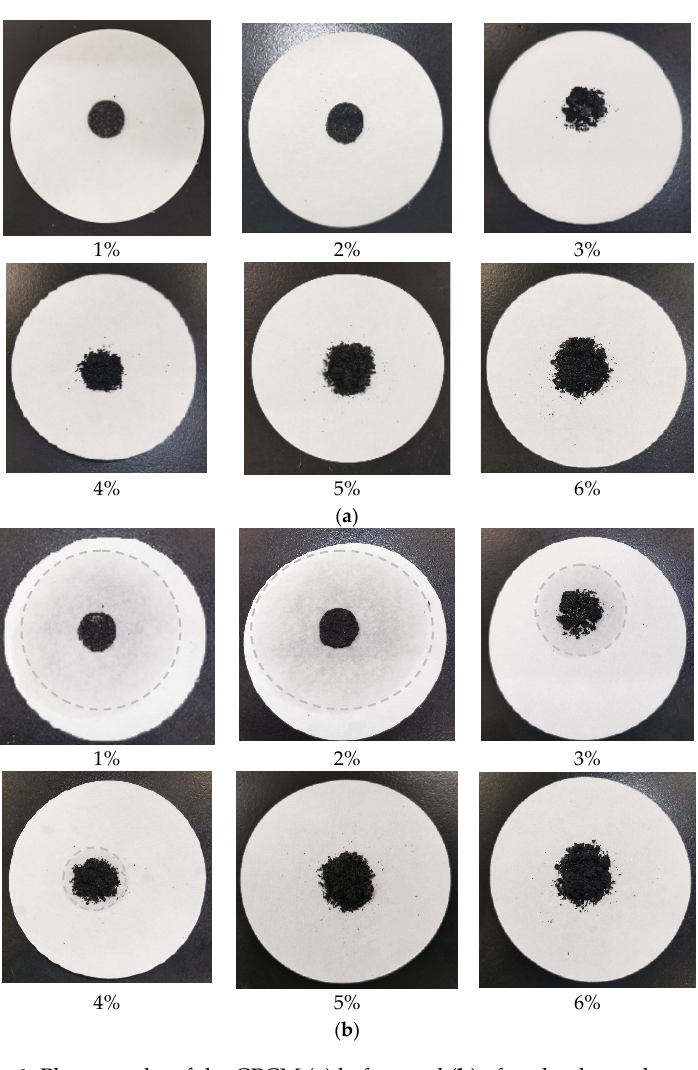
Figure 6. Photographs of the CPCM ( a ) before and ( b ) after the thermal treatment. Energies 2020 , 13 , x FOR PEER REVIEW